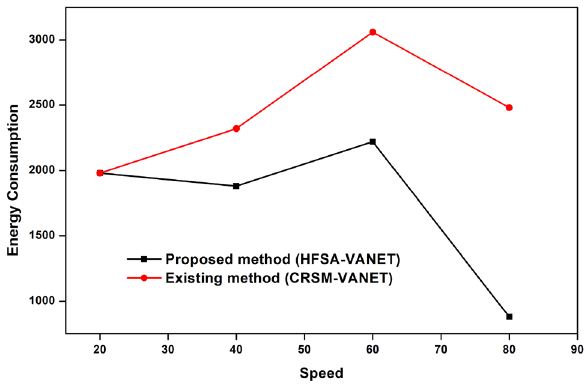
Figure 9. Speed vs energy consumption plot for a proposed and existing method.